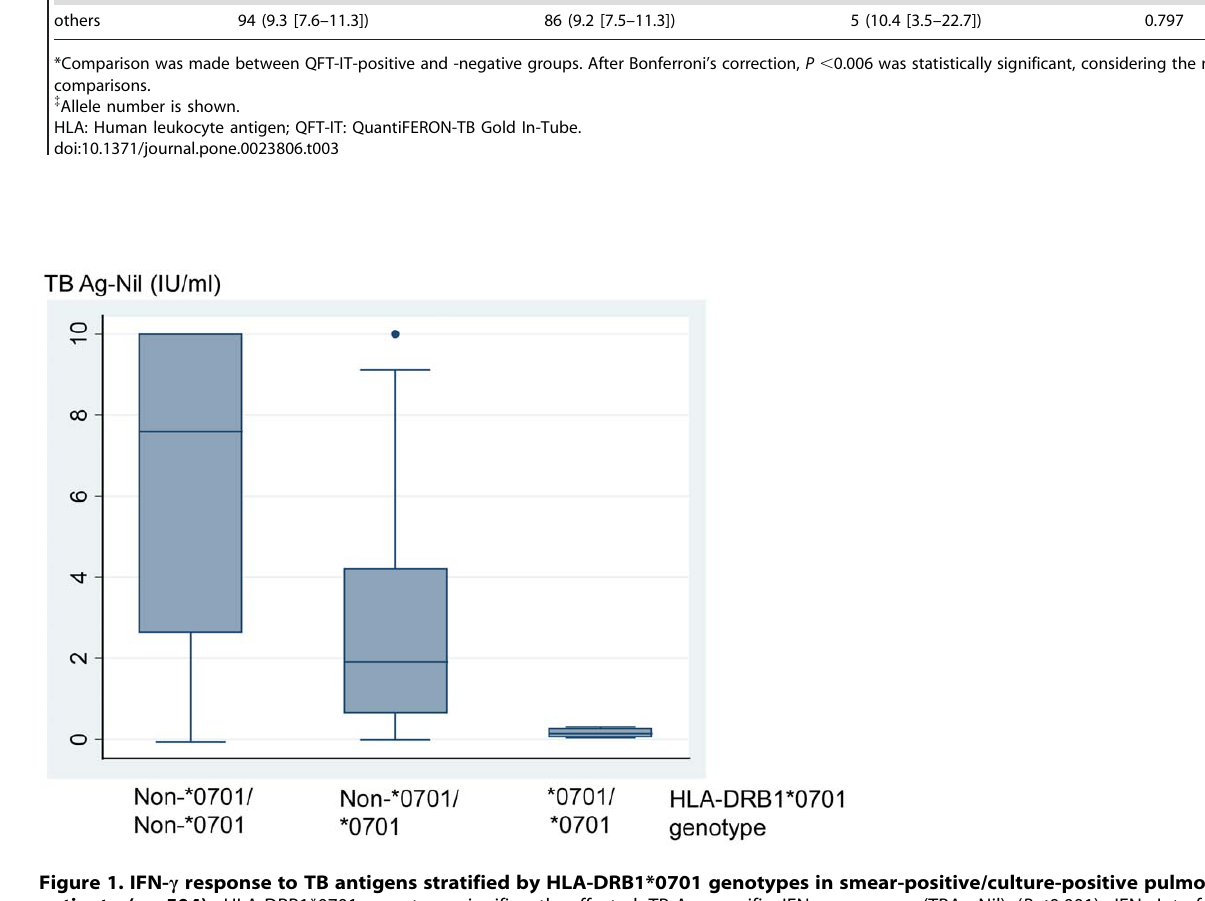
Figure 1. IFN- c response to TB antigens stratified by HLA-DRB1*0701 genotypes in smear-positive/culture-positive pulmonary TB patients (n=504). HLA-DRB1*0701 genotype significantly affected TB-Ag specific IFN- c response (TBAg-Nil) ( P , 0.001). IFN: Interferon; TB: Tuberculosis; HLA: Human leukocyte antigen; Ag: Antigen.